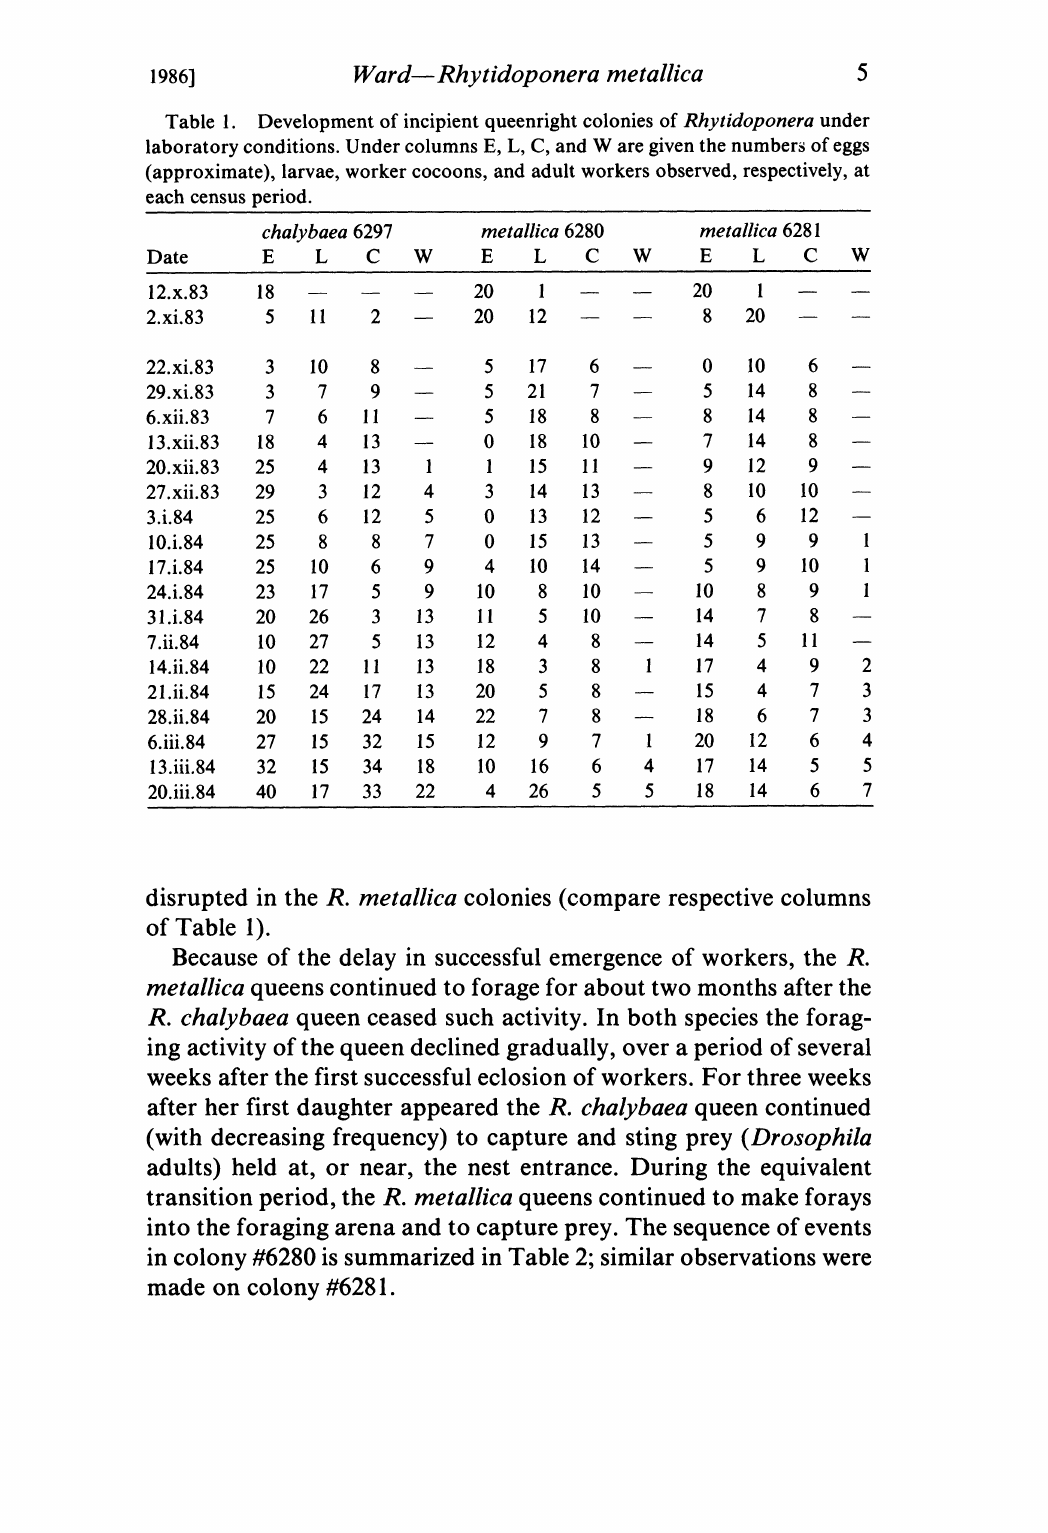
Table 1. Development of incipient queenright colonies of Rhytidoponera under laboratory conditions. Under columns E, L, C, and W are given the numbers of eggs (approximate), larvae, worker cocoons, and adult workers observed, respectively, at each census